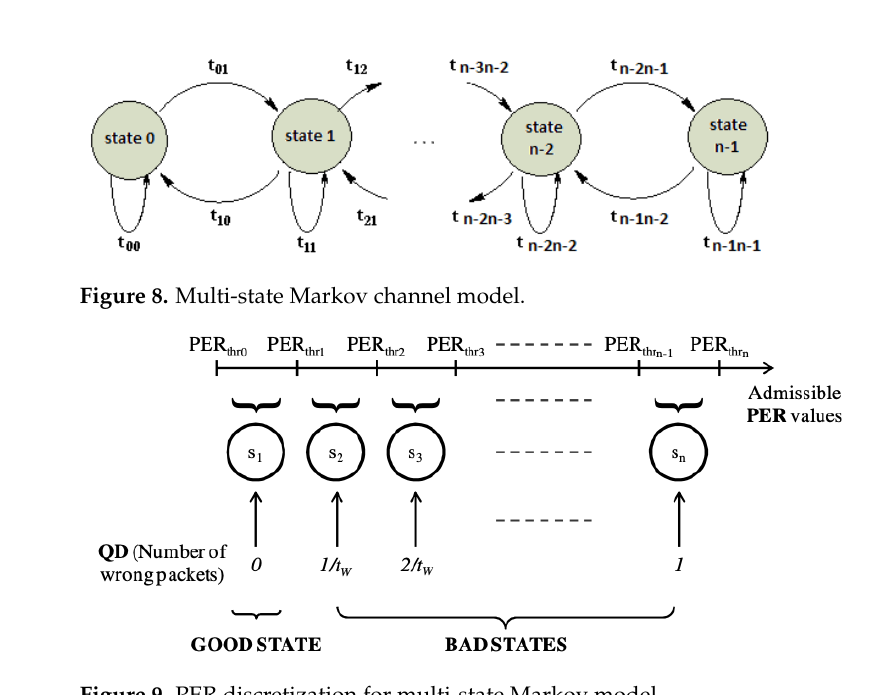
Figure 9. PER discretization for multi-state Markov